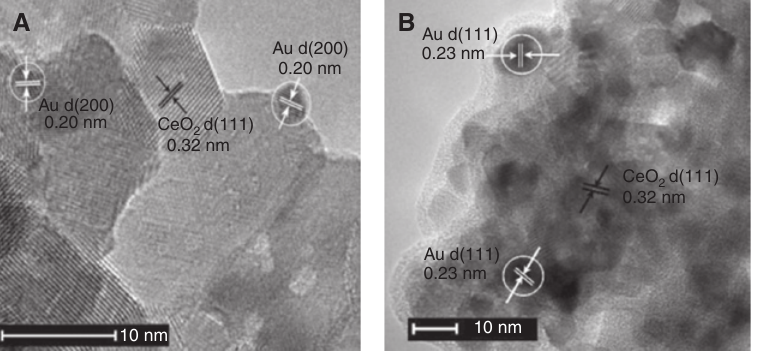
catalysts. (A) Au/CeO 2